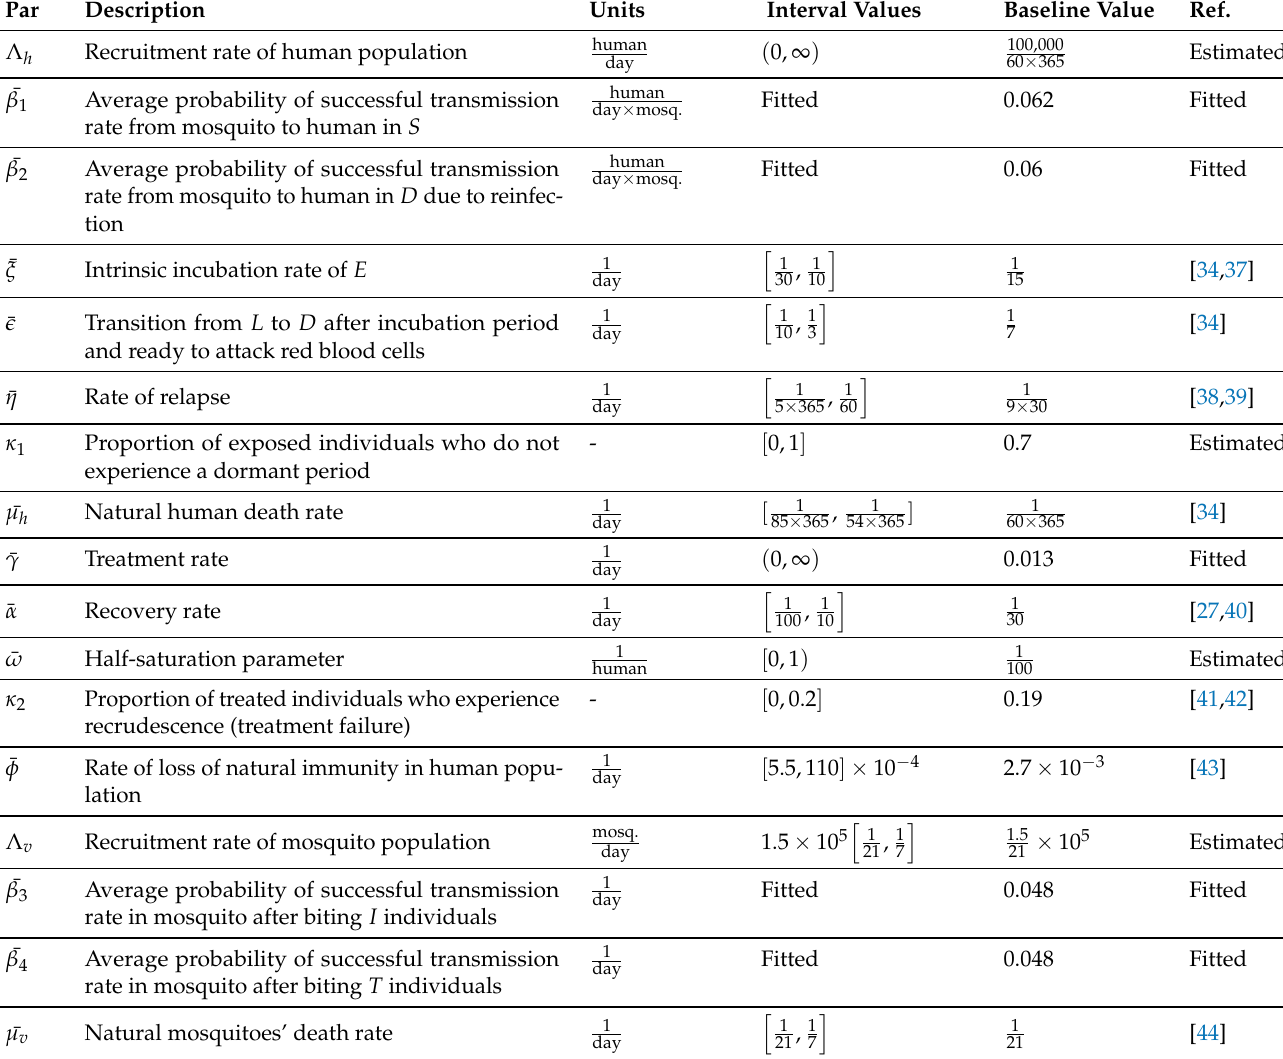
Table 1. Description of parameters of the model (See Supplementary file, Equation (S1) for the